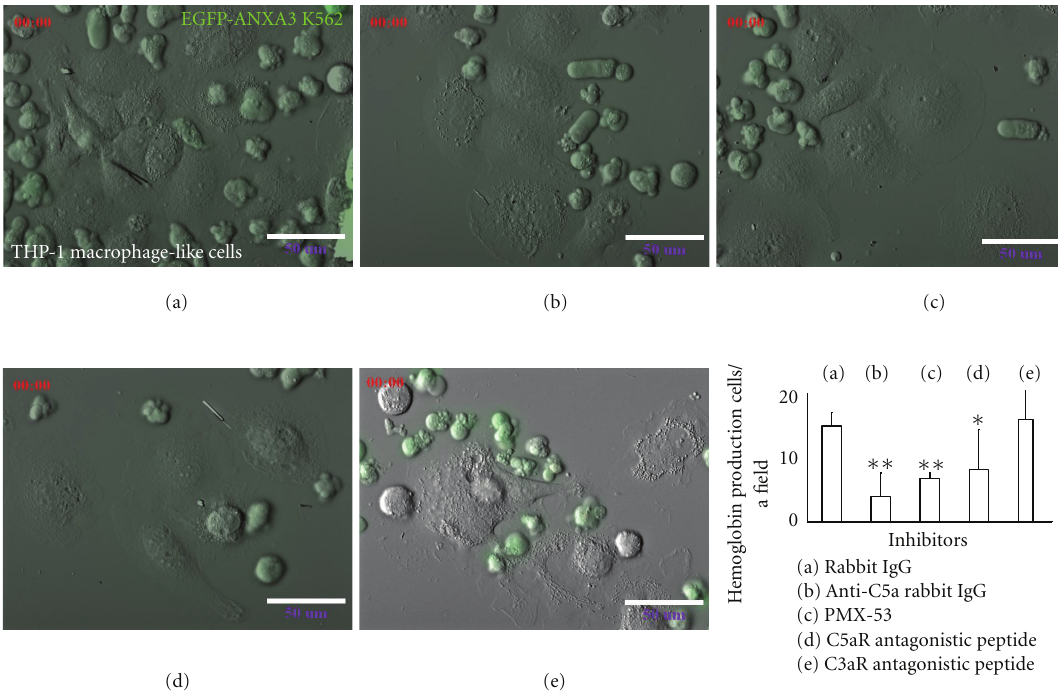
Figure 7: Detection of the inhibition of the K562-THP-1 cell interactions by the inhibitors of the C5aR-RP S19 oligomer system using time- lapse microscopy. ((a)–(e)) EGFP-ANXA3-overexpressing K562 cells were cultured with the THP-1 macrophage-like cells in the presence of control rabbit IgG, anti-C5a rabbit IgG, PMX-53, W-54011, or SB 290157 for 1–3 days and were recorded using the LCV110 microscope ( n = 3). The maximal number of cells containing haemoglobin-like molecules at 72 hr of coculturing was counted automatically from 4 random fields, and the averages were calculated. P values of less than 0.05 were considered statistically significant ( ∗ P < 0 . 05 or ∗∗ P < 0 .